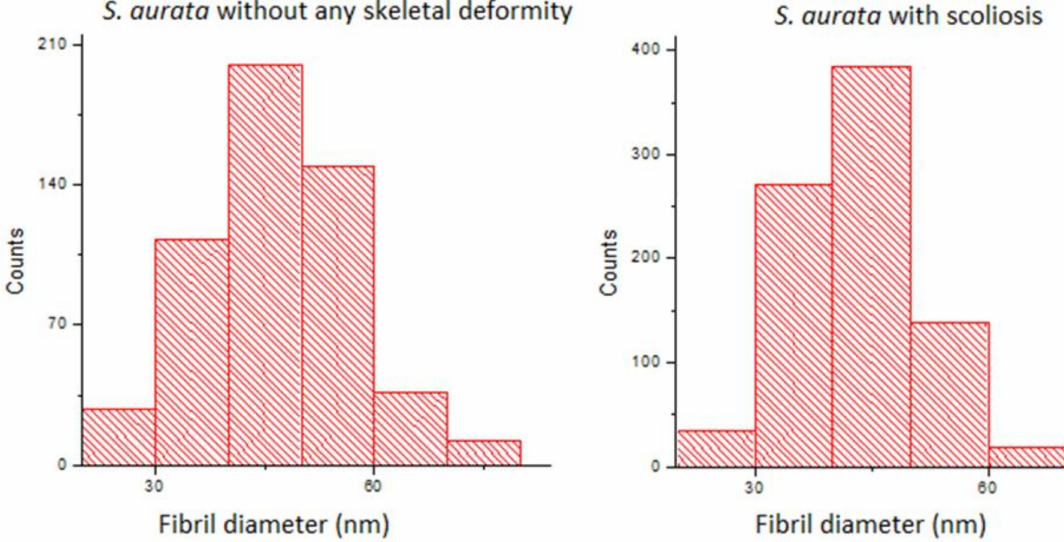
Figure 5. Histogram of vertebral collagen fibril diameter (nm) of the non-deformed seabreams and the scoliotic ones. In the scoliotic seabreams, the collagen fibrils with a diameter smaller than 50 nm are much more than the non-deformed ones, leading to a significantly decreased mean collagen fibril